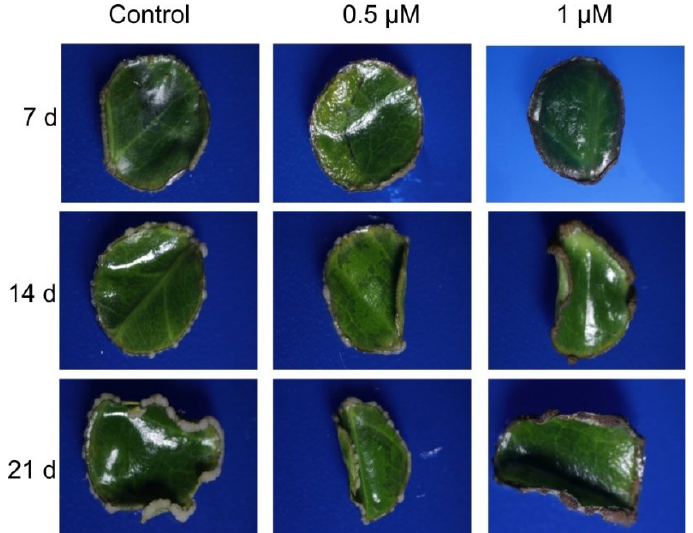
Figure 6. Induction of SE in C. canephora in the presence of pravastatin (PVS). The SE process was performed as described in the methodology with some modifications. PVS was added only in the preconditioning stage.